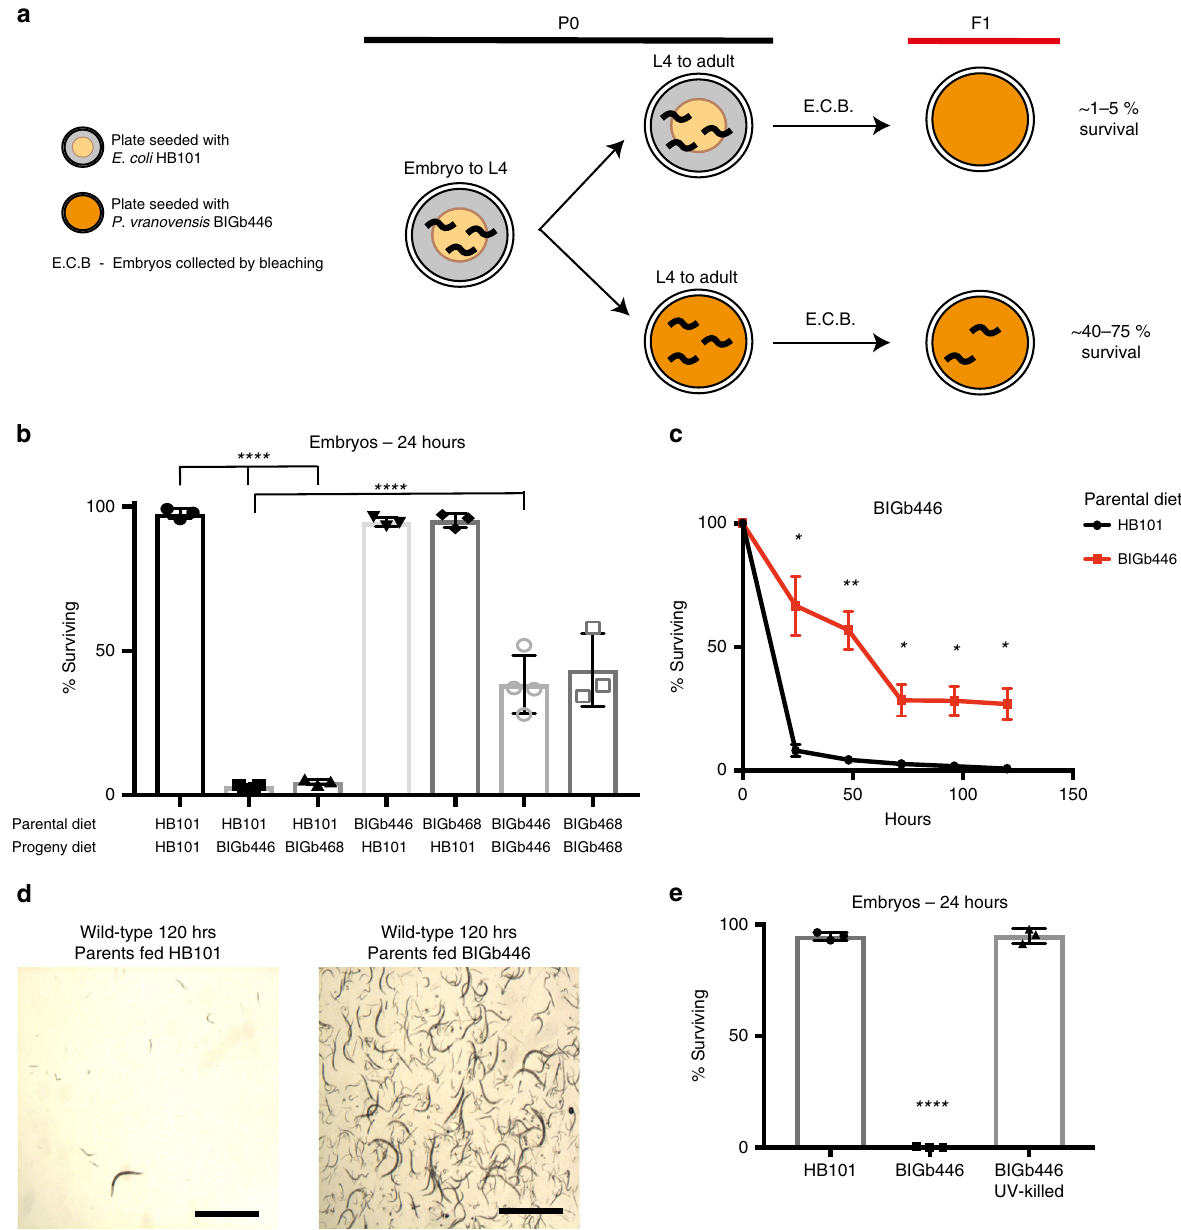
Fig. 1 C. elegans heritably adapts to infection by Pseudomonas vranovensis . a Graphical representation of experimental set up. Embryos collected